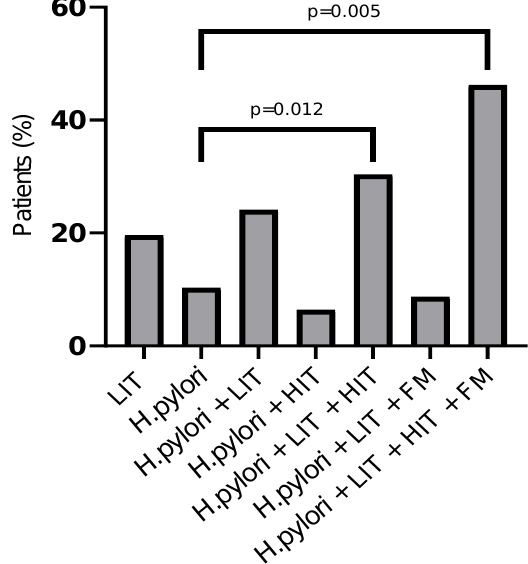
Figure 2: Sixty nine of 378 LIT patients indicated abdominal pain during lactose H 2 breath tests. Ab- dominal pain was specified by 30 of 153 LIT pa- tients (19.6 %), seven of 68 patients with H. pylori (10.3 %), 14 patients of 58 H. pylori and LIT pa- tients (24.1 %), three of 47 H. pylori and HIT pa- tients (6.4 %), 14 of 46 H. pylori and LIT with HIT patients (33.4 %), two of 23 H. pylori , LIT and FM patients (8.7 %) and in six patients of 13 H. pylori , LIT, HIT with FM patients (46.2